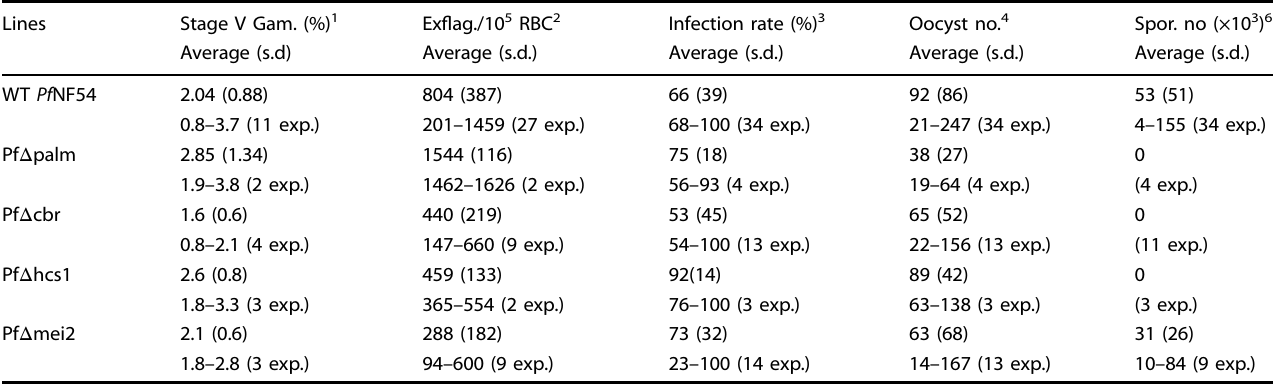
Table 2. Gametocyte, oocyst, and sporozoite production of four P. falciparum gene-deletion mutants and wild-type WT Pf NF54.